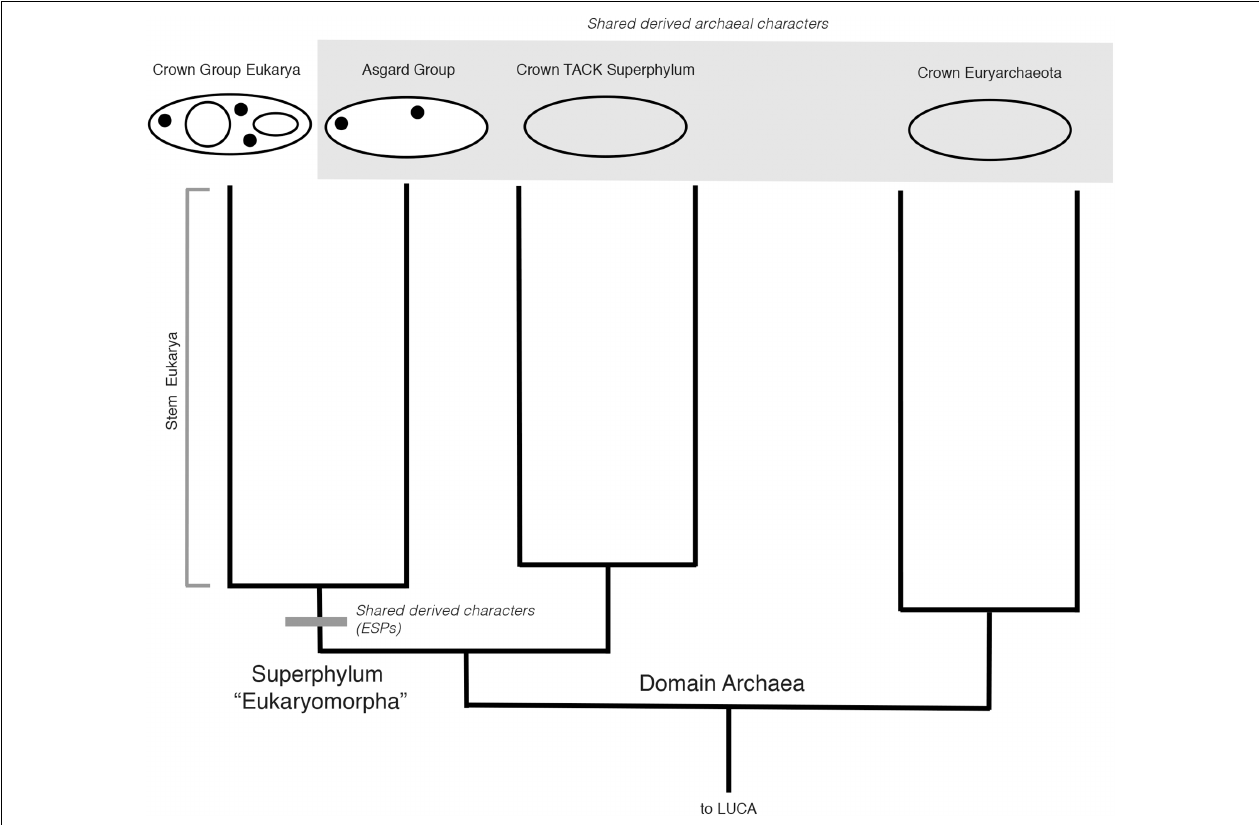
FIGURE 3 | Hypothetical rooted archaeal tree including Asgard and eukaryotes, consistent with a “2-Domain” topology. With this rooting, the Asgard + Eukarya clade is nested within Archaea, i.e., the last common ancestor of all Archaea (excluding Asgard) is also the last common ancestor of Eukarya and Asgard. As such, Asgard + Eukarya constitute a clade of unequal taxonomic rank to Archaea. Note that the scenarios in Figures 2 , 3 only differ in the placement of the root, not in the topology of the tree or mapping of the